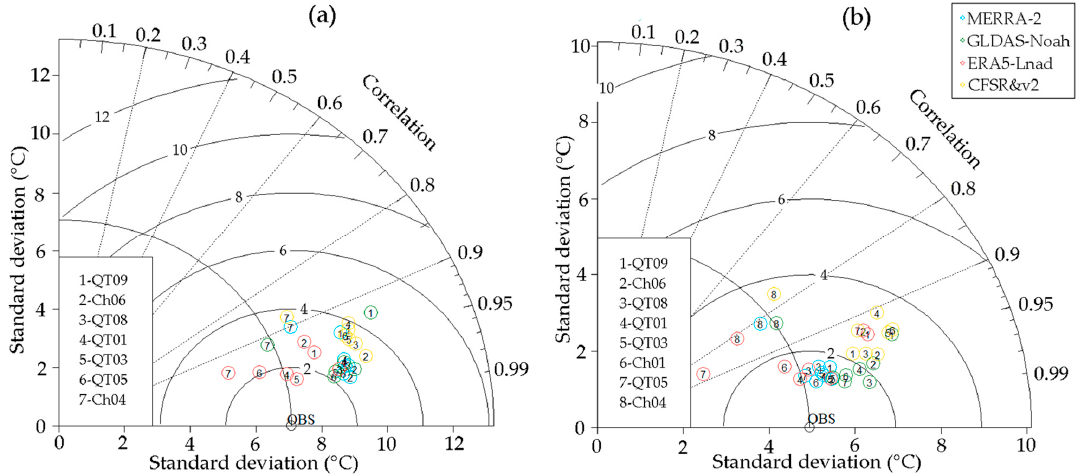
Figure 5. Taylor program for measured soil temperature data at 10 cm ( a ) and 50 cm ( b ) compared with the reanalysis soil temperature. (Missing 10 cm records at Ch01 site due to equipment failure).